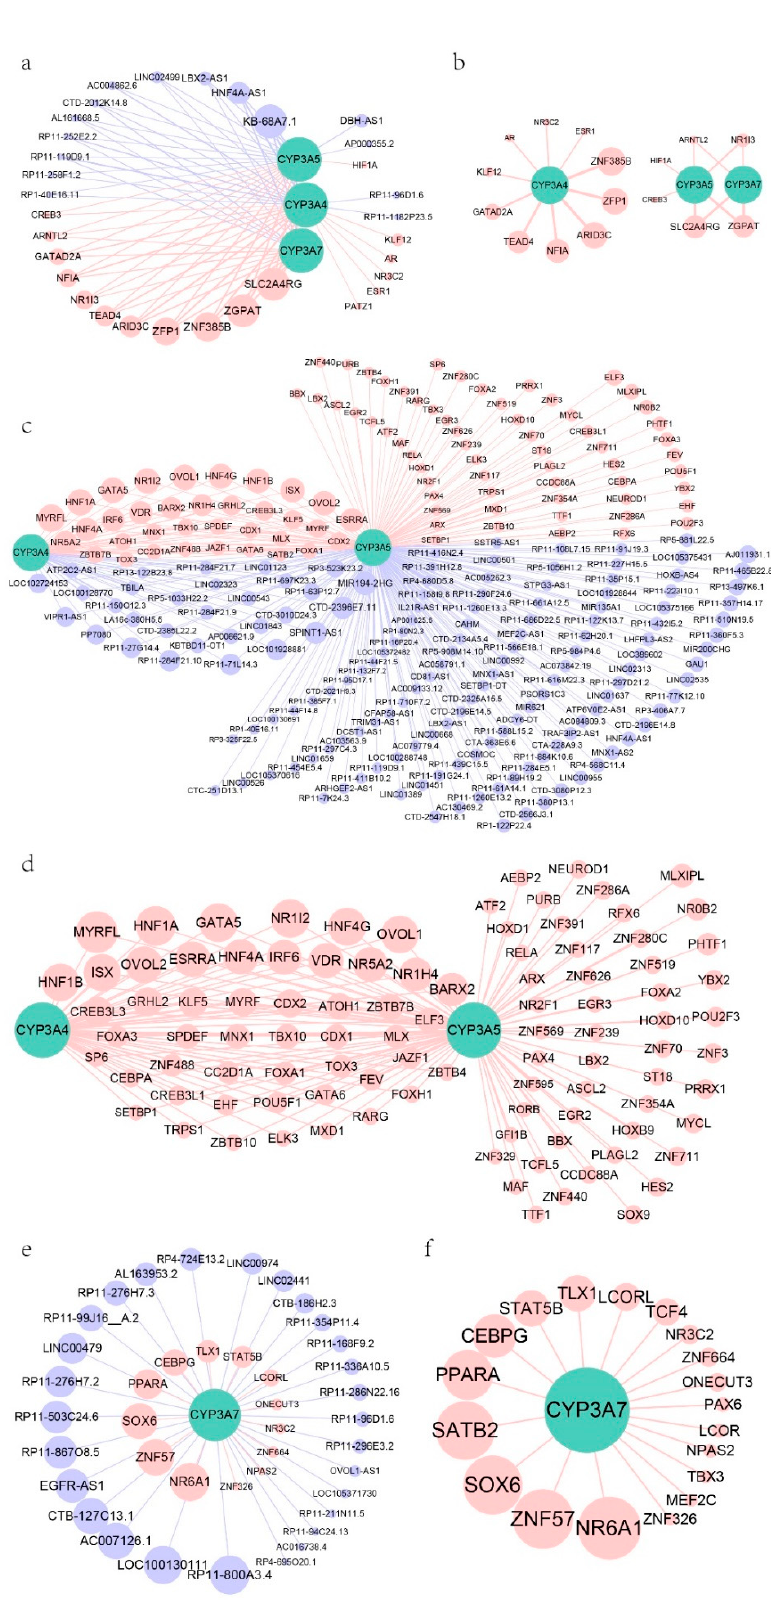
Figure 4. The direct co-expression relationships among TFs, lncRNAs, and CYP3A4, 3A5, and 3A7 . ( a ) The co-expression network of TFs, ncRNAs, and CYP3A s in group 1 and all TFs and ncRNAs with weight values > 0.1. ( b ) The co-expression network in group 3 (weight value > 0.1). ( c ) The co- expression network of TFs, ncRNAs, CYP3A4 , and 3A5 in group 2. ( d ) The co-expression network